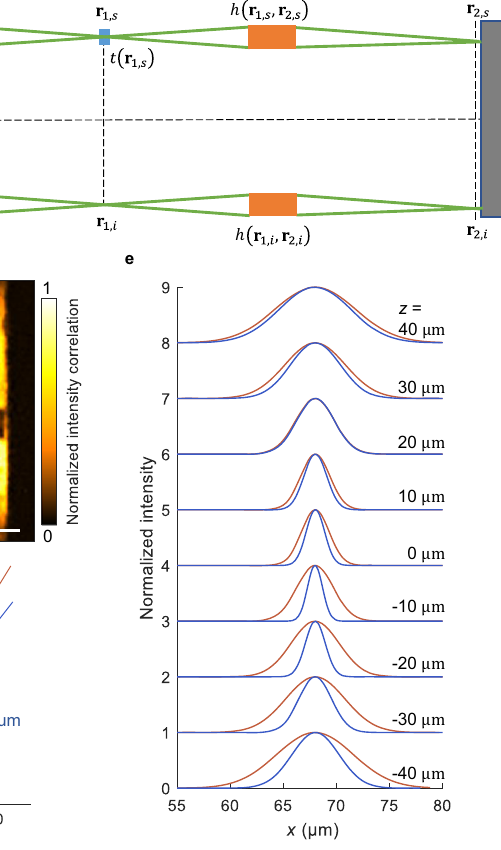
Fig. 3 | Spatial resolution of QMC. a Simple schematic of QMC. BBO, β -barium borate crystal. EMCCD, electron multiplying charge-coupled device camera. r 0 , r 1 , and r 2 are the coordinates of the source Fourier plane, the object plane, and the detectionplane,respectively. r